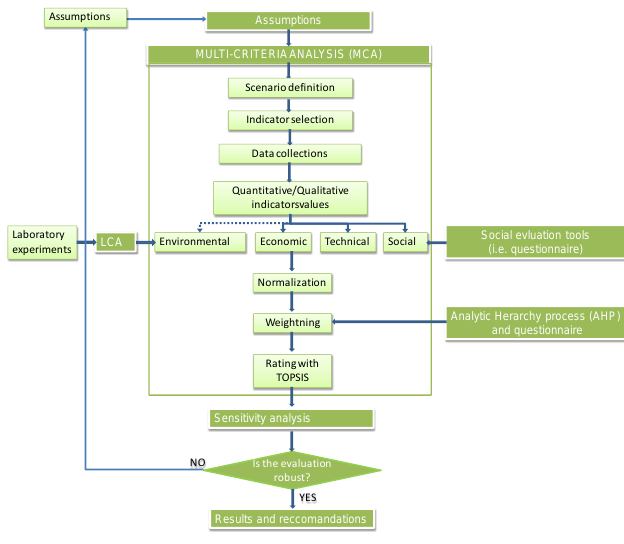
Fig. 1. Methodology concept for the sustainability analysis. Looking towards the selection of the